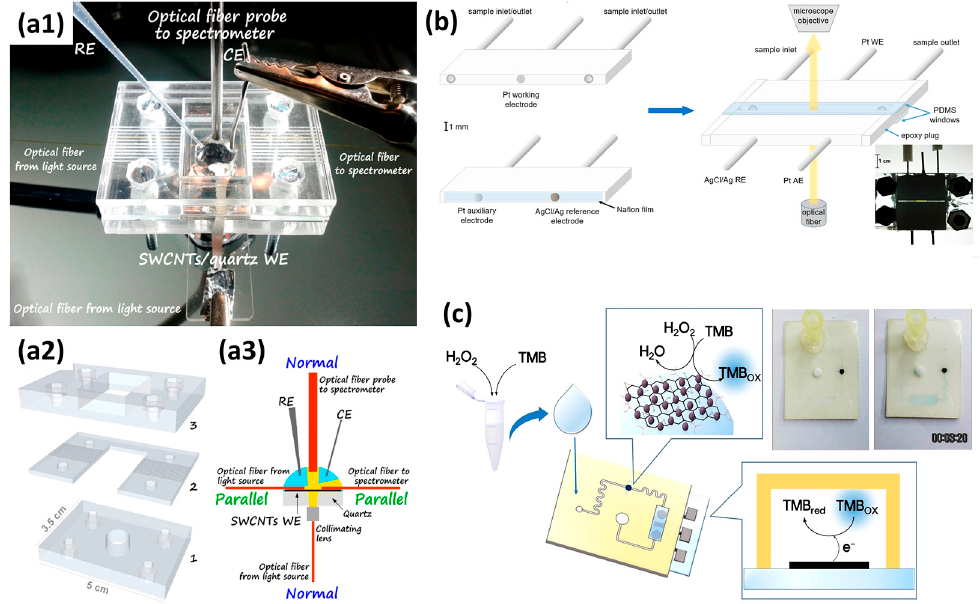
Figure 10. ( a1 ) a Photograph of the assembled cell ready to measure, ( a2 ) a schematic view of the disassembled cell, and ( a3 ) a detailed schematic view of the experimental setup. Reprinted from [174], with permission from ACS Publications. ( b ) Illustration of the microfluidic setup for UV-Vis SEC measurements. Reprinted from [175], with permission from Elsevier. ( c ) A schematic diagram of H 2 O 2 detection on electrochemical POC devices with Au@PtNP/GO nanozymes. Reprinted from [172], with permission from Elsevier.